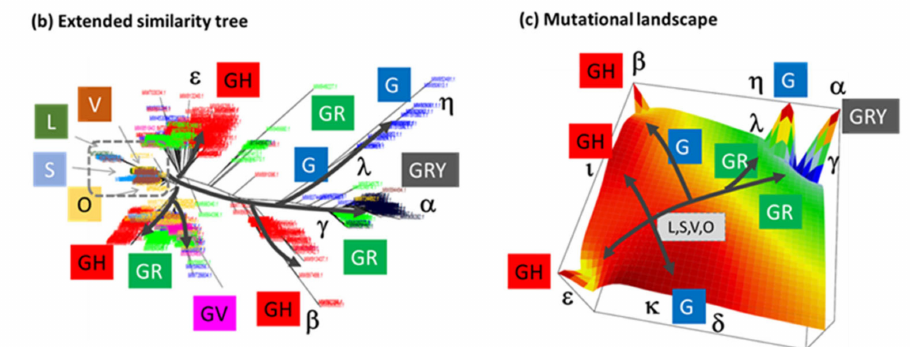
Figure 9. Pseudotime (PT) analysis of SARS-CoV-2 development. ( a ) Tree sorts the variants along ten branches each leading to one VOC/VOI. The variants were colored using WHO VOC/VOI (left part) or GISAID groups. The stacked composition plots reveal that the non-VOC variants were progressively replaced with VOC variants with increasing PT in a branch specific fashion. ( b ) The similarity tree reflects development of the virus in direction of the arrows. For better resolution, the number of SARS-CoV-2 genomes was increased to 1241 using xSOM (see next subsection). ( c ) Development in SNV-state space between GISAID clades. See also Figures A9 and